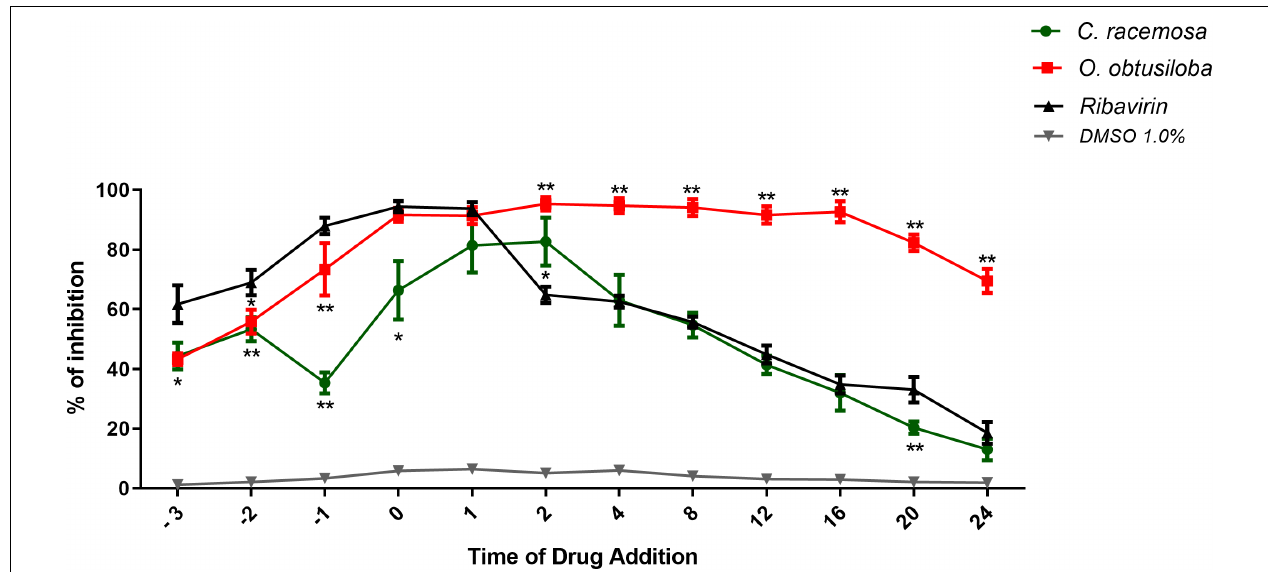
FIGURE 6 | Time of drug addiction studies with C. racemosa , O. obtusiloba , and K. alvarezii crude extracts on CHIKV replication. Vero cells were infected with CHIKV (10 6 PFU/mL) on MOI of 0.1 following each treatment (before the infection, –3, –2, and –1 h; during the infection, 0h; and after the infection, +1, +2, +4, +8, +12, +16, +20, and +24 h), the results were evaluated by plaque assay. Experiments were performed in triplicate. Ribavirin (5 µ M) was used as a positive control. ∗ p < 0.05; ∗∗ p < 0.01 in Dunnett test vs. control (Ribavirin). DMSO used as solvent remained at the final concentration of 0.01% showing no activity on CHIKV